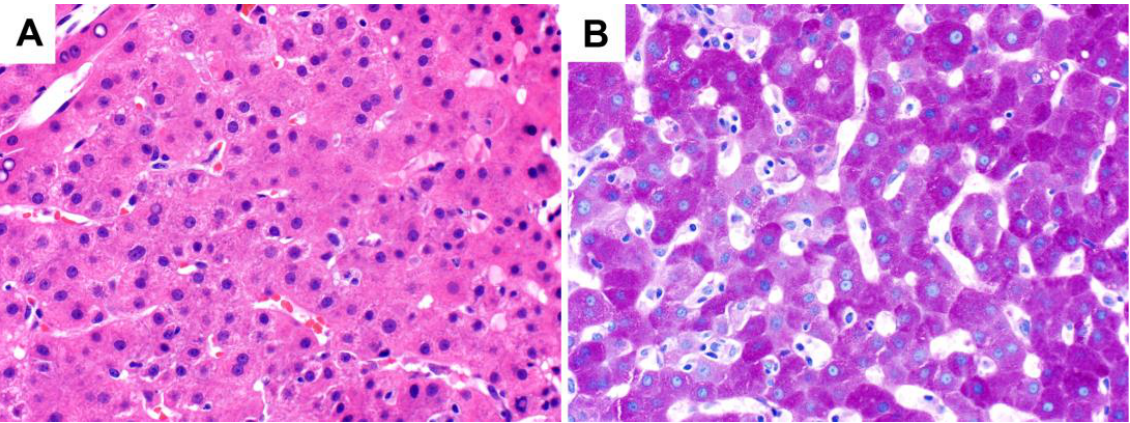
Figure 1. H&E and PAS staining characteristics in the normal liver (original magnification 400×): ( A ) H&E stain; ( B ) PAS stain.